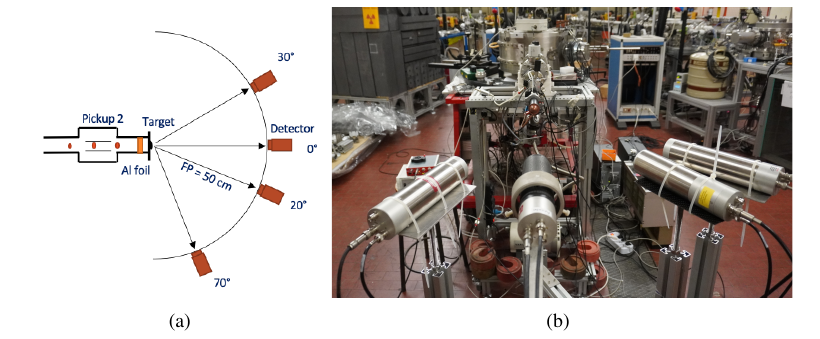
Figure 2. a) Schematic representation of the experimental setup. b) Experimental setup.